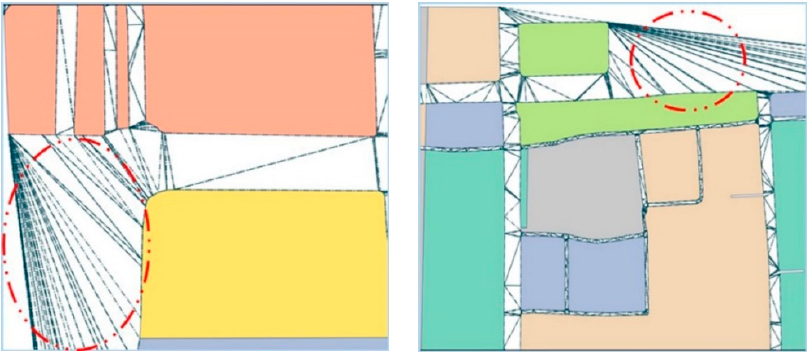
Figure 5. Illustration of long and thin triangles.